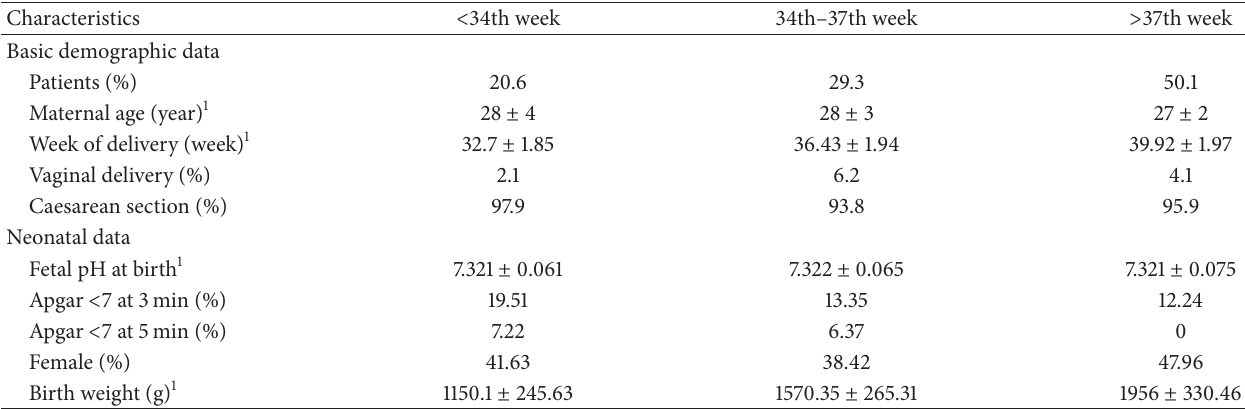
Table 1: Maternal and perinatal characteristics.